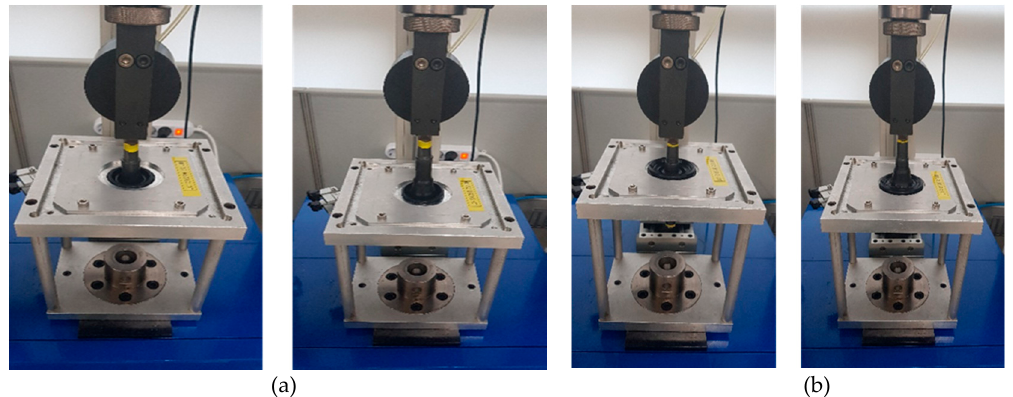
Figure 5. Measurement of the insertion and separation forces: ( a ) depicts the measurement of the insertion force; ( b ) shows that of the separation force.